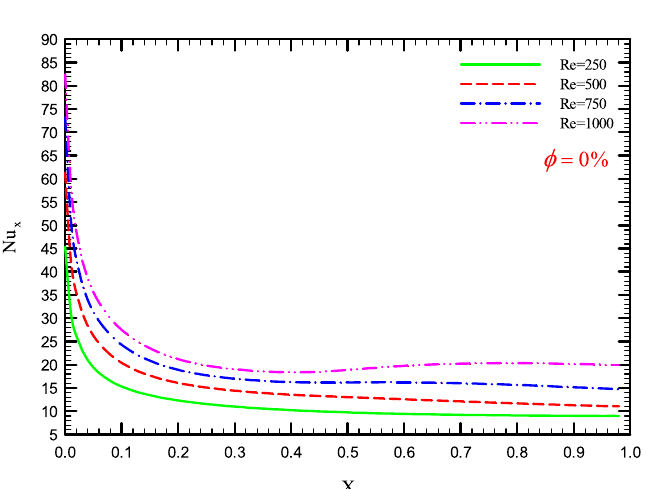
Figure 7. Nu x versus dimensionless length in φ = 0% for Case